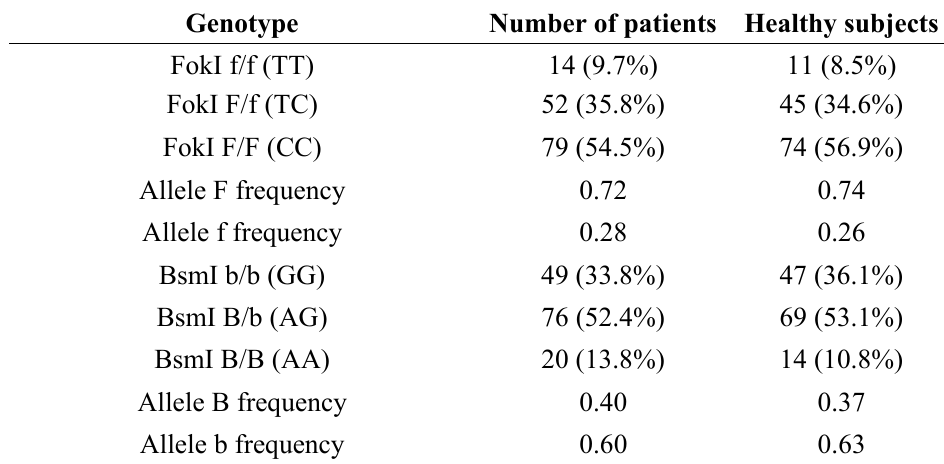
Table 2. Vitamin D receptor (VDR) genetic background of the sampled CKD 3b population .